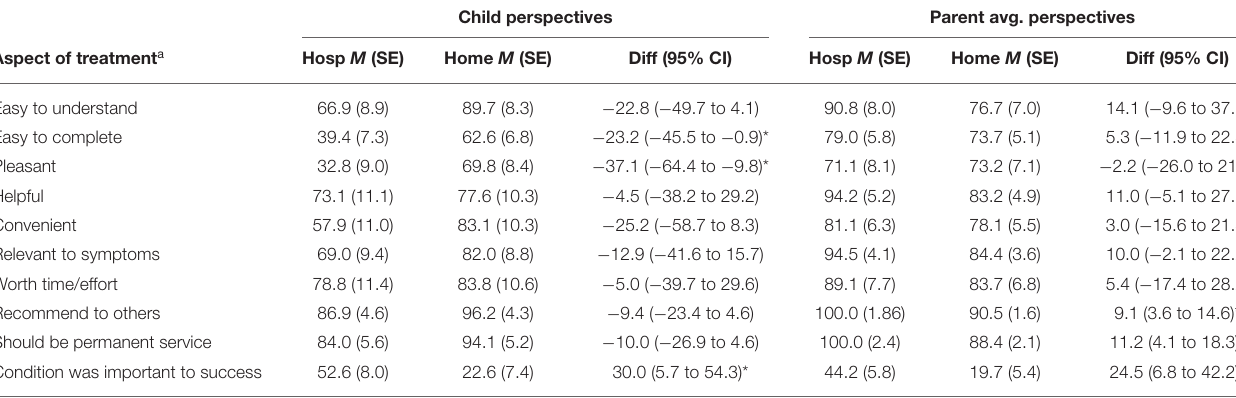
TABLE 4 | Youth and parent perspectives regarding treatment with comparisons between groups.